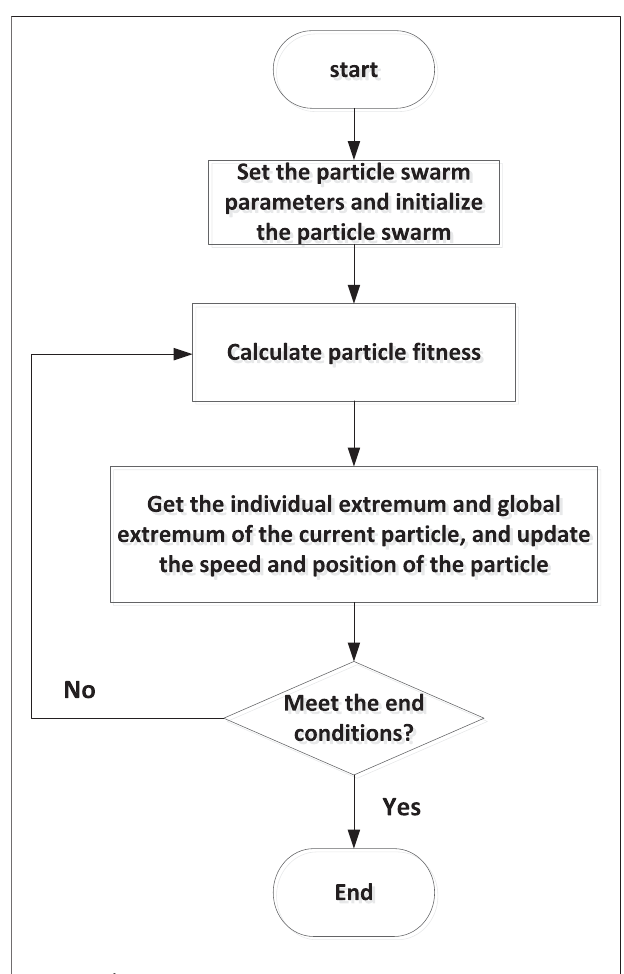
FIGURE 2 | Particle swarm optimization